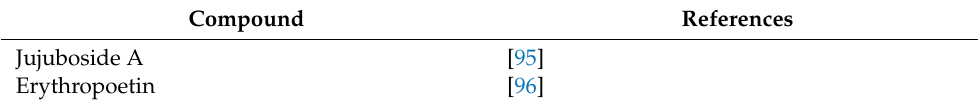
Table 6. Inducers of Hsp90 β